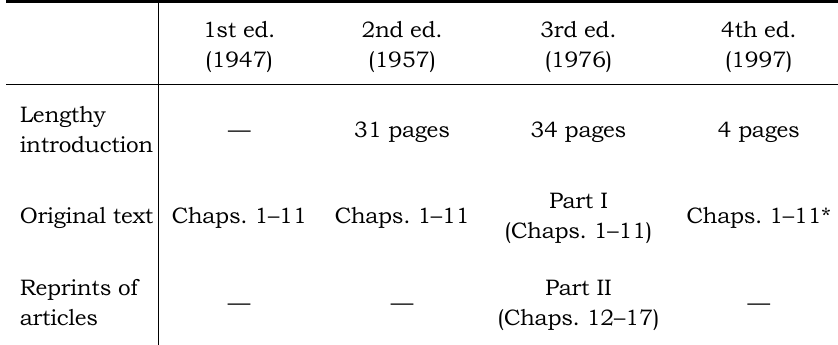
Table 1. Structural transitions from the first to the fourth